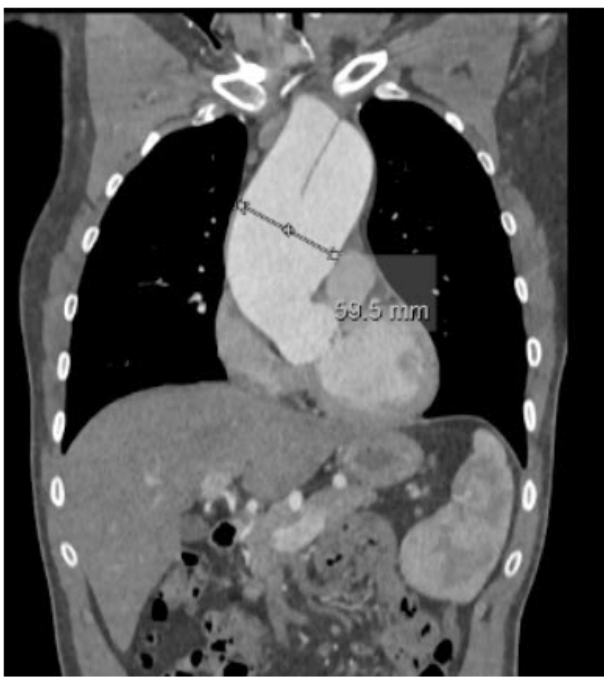
Fig. 2 – Thoraco-abdominal CT scan on the day of the first diagnosis, showing aortic aneurysm and dissection membrane.